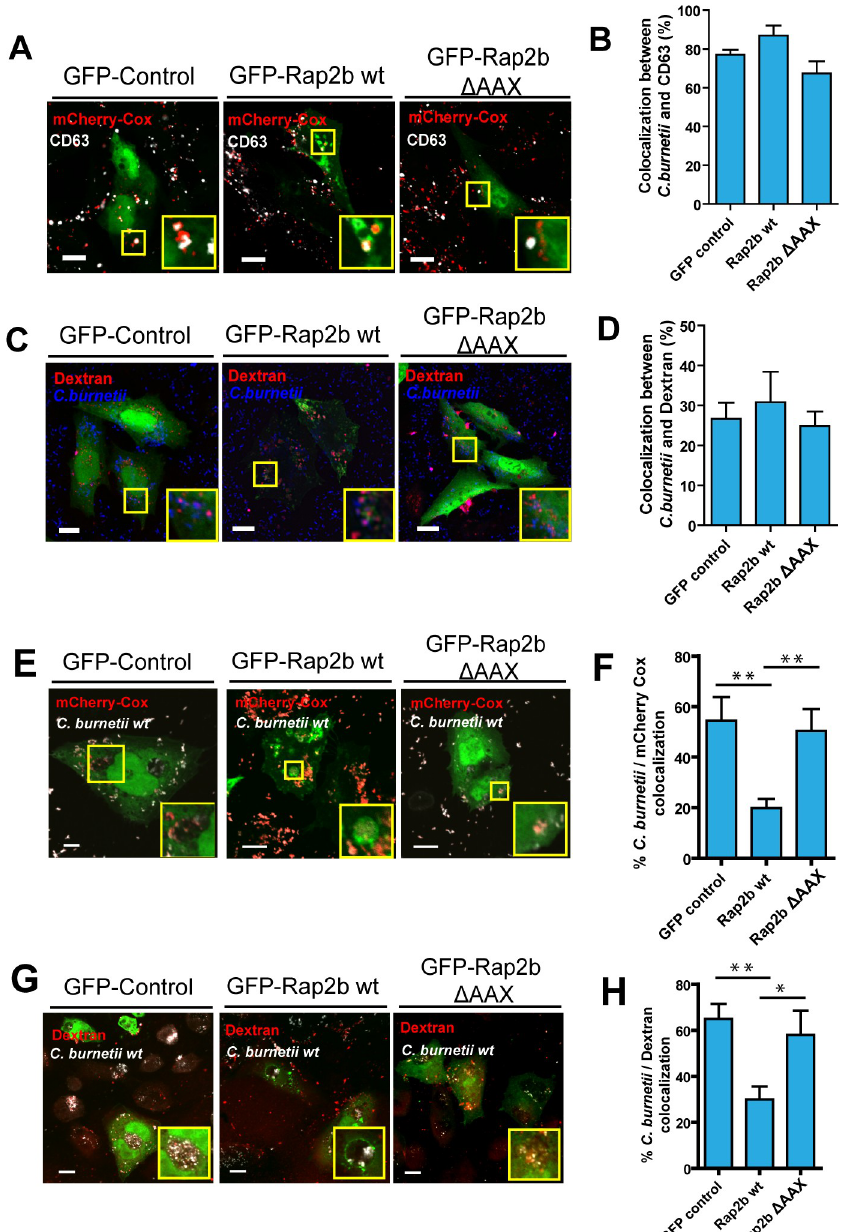
Fig 5. Homotypic fusion between phagosomes containing C . burnetii and the replicative vacuole is altered by overexpression of Rap2b wt at later times of infection. A. CHO cells were transfected with pEGFP, wt pEGFP-Rap2b or pEGFP-Rap2b Δ AAX. After 24 hours the cells were infected with mCherry- C . burnetii for 2 hours, fixed and subjected to indirect immunofluorescence using antibodies against CD63 (MOI = 10). B. Quantification of colocalization between C burnetii and CD63. C. CHO cells were transfected with pEGFP (control), wt pEGFP-Rap2b or pEGFP-Rap2b Δ AAX and were incubated for 2 hours with 5 μ g/ml dextran-rhodamine to allow the labeling of lysosomes. After 24 hours, the cells were infected with C . burnetii for 2 h, fixed and subjected to indirect immunofluorescence using antibodies against C . burnetii (blue). D. Quantification of colocalization between dextran and C . burnetii . The data represent the mean ± SEM of at least 3 independent experiments. Tukey test � p � 0.05. Bars = 10 μ m. E. CHO cells were infected with C . burnetii for 24 hours and then transfected with pEGFP, pEGFP-Rap2b or pEGFP-Rap2b Δ AAX. After 24 hours, cells were infected with C . burneti mCherry for 4 h (early phagosomes), fixed and analyzed by confocal microscopy. F. Quantification of the arrival of mCherry- C . burnetii (red) to the vacuole of C . burnetii already formed. G. CHO cells were infected with C . burnetii for 24 h and then transfected with pEGFP, wt pEGFP-Rap2b or pEGFP-Rap2b Δ AAX. After 24 hours, cells were incubated with Texas red